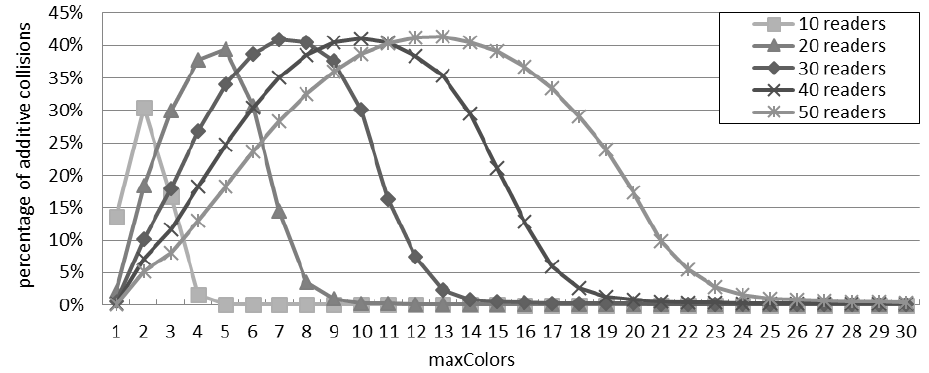
Figure 11. Percentage of additive collisions for the additive interference model in the DCS